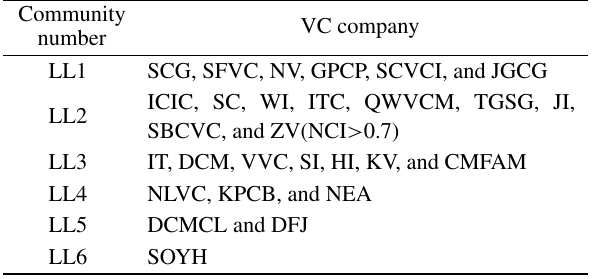
Table 8 VC companies with NCI greater than 0.6 in LL detection results.